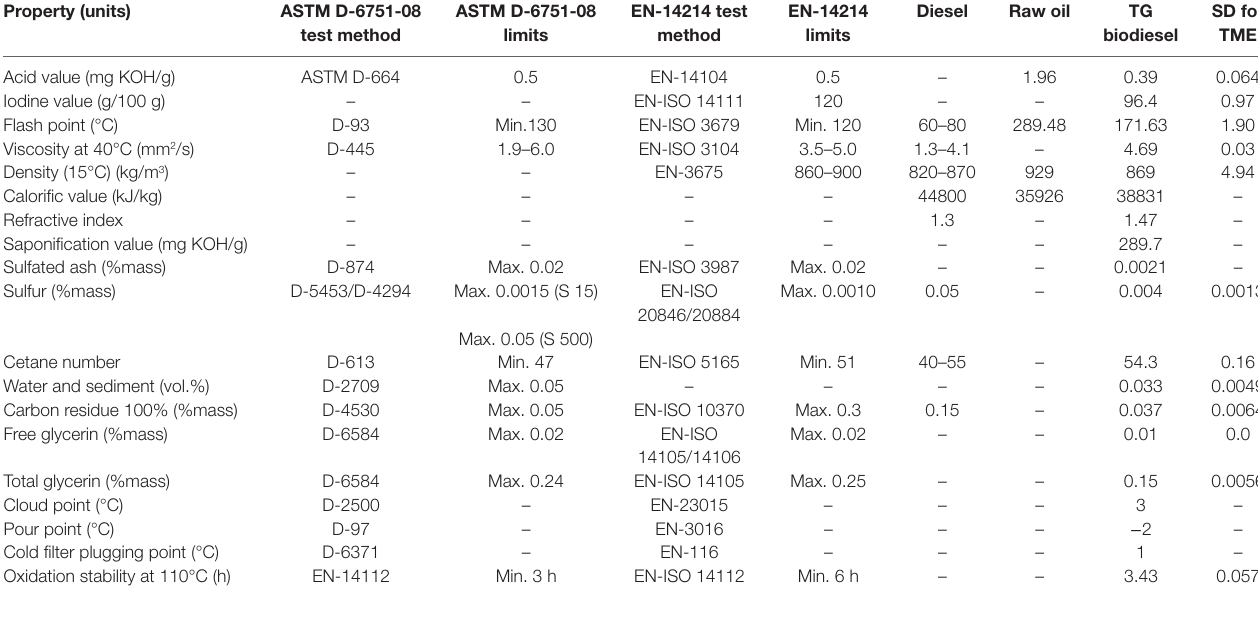
TaBle 2 | Physicochemical properties of TG raw oil, TG biodiesel and mineral diesel with standard limits as per ASTM D-6751 and EN-14214 specifications. Property